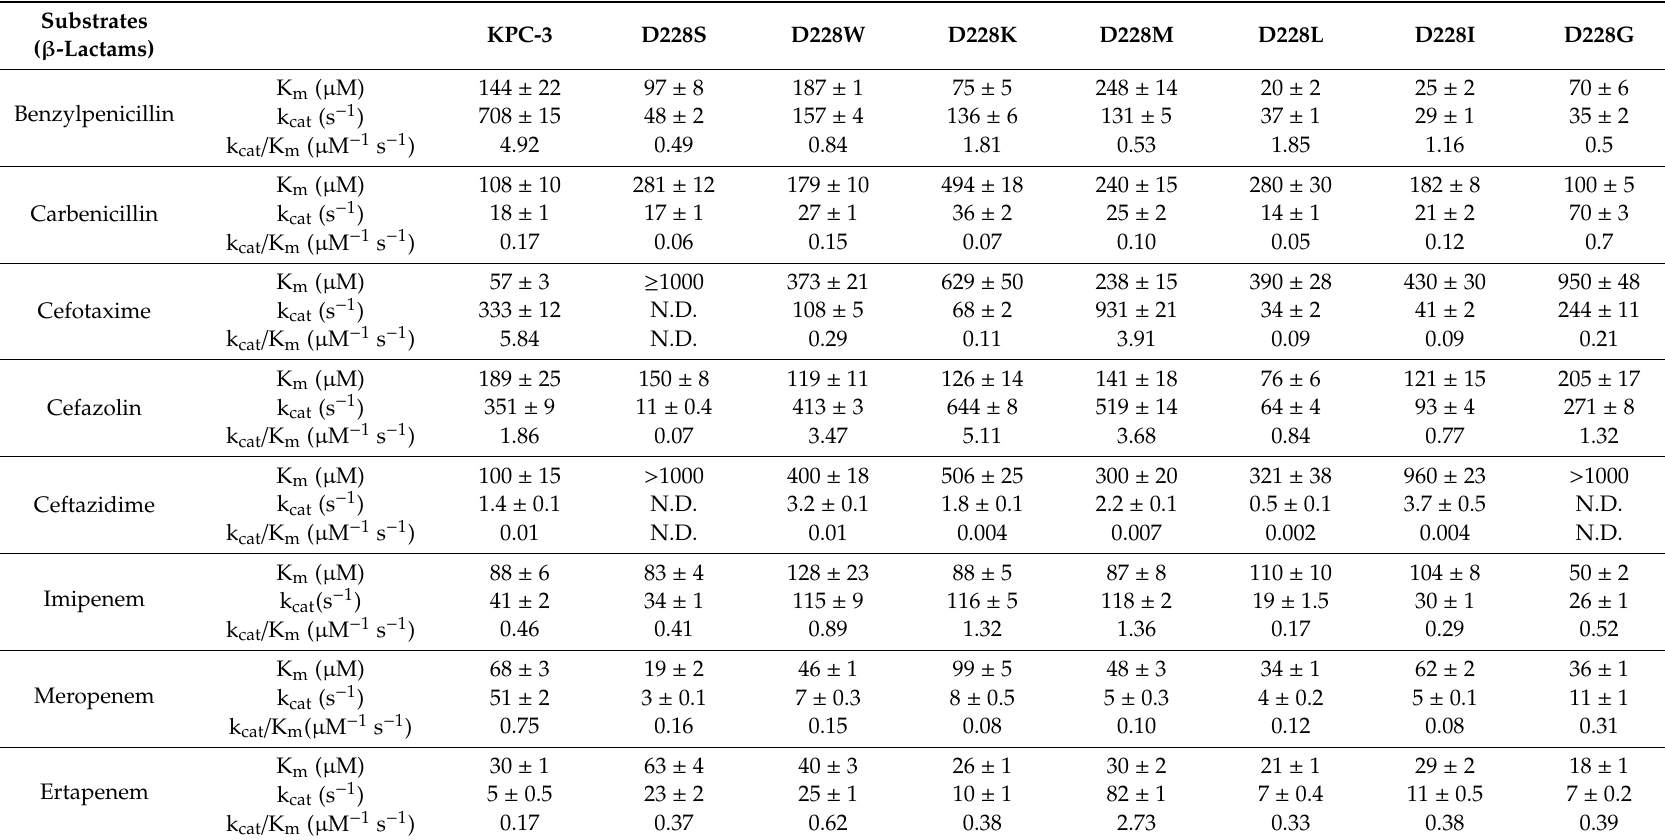
Table 1. Kinetic parameters calculated for KPC-3 laboratory mutants towards some β